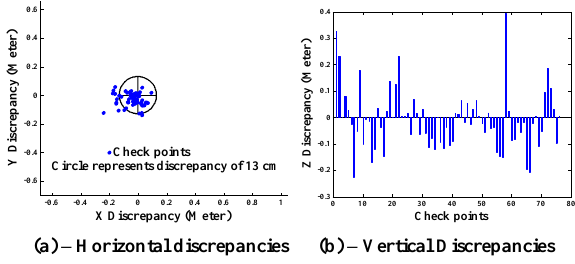
Figure 8. Horizontal e vertical discrepancies of check points (second block) from ISO experiment with control points and IOP from in situ calibration